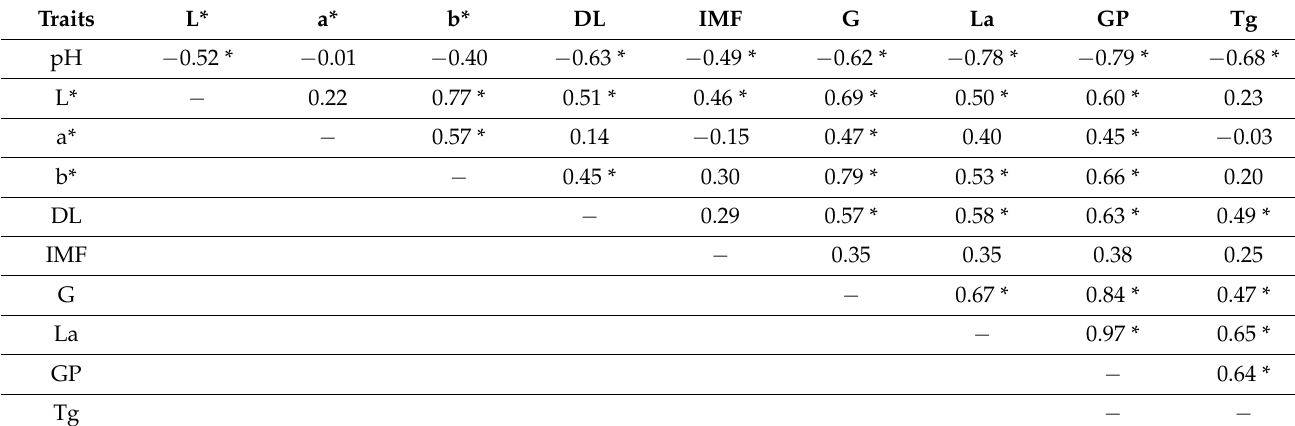
Table 2. Pearson’s simple correlation coefficients between the examined